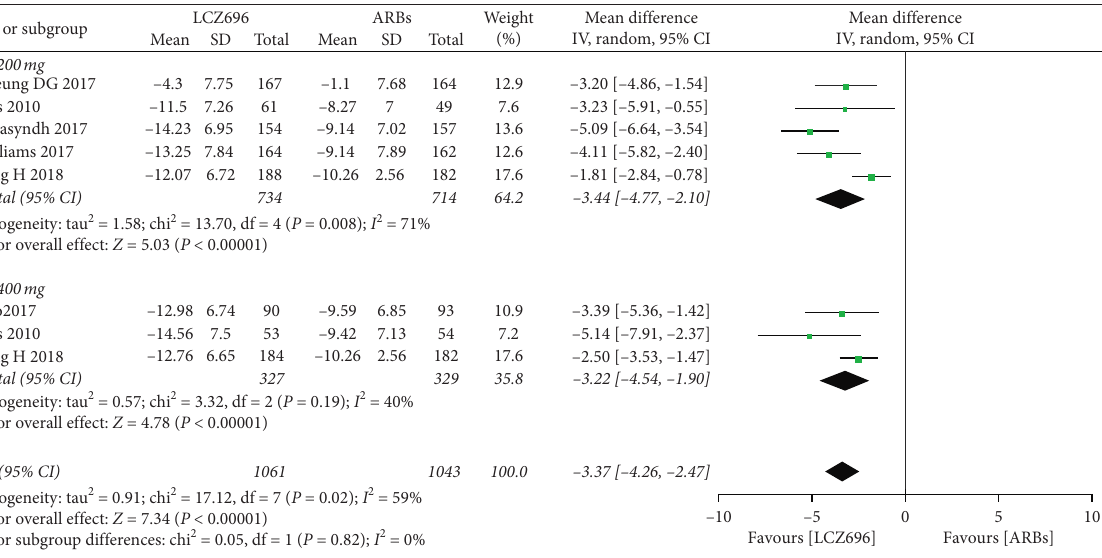
Figure 5: Comparison of LCZ696 with ARBs on mean reduction (mm Hg) in ambulatory systolic blood pressure (maSBP). LCZ696 Study or subgroup